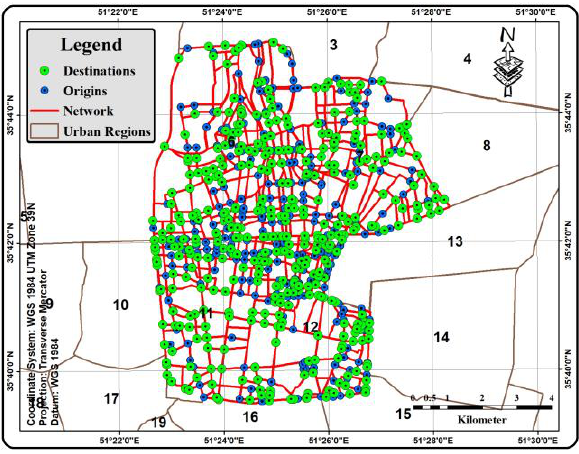
Figure 8. The origins and destinations of passengers